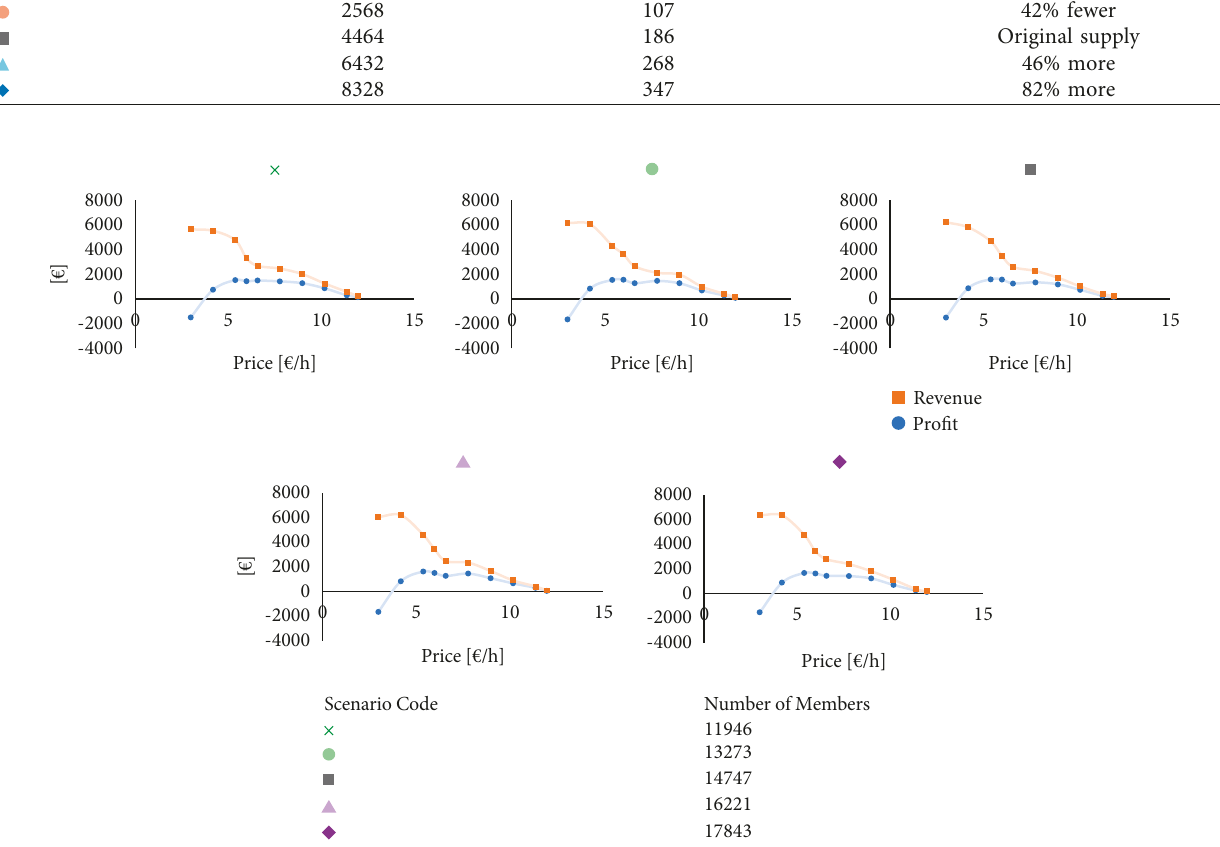
Figure 5: Revenue and profit by potential demand